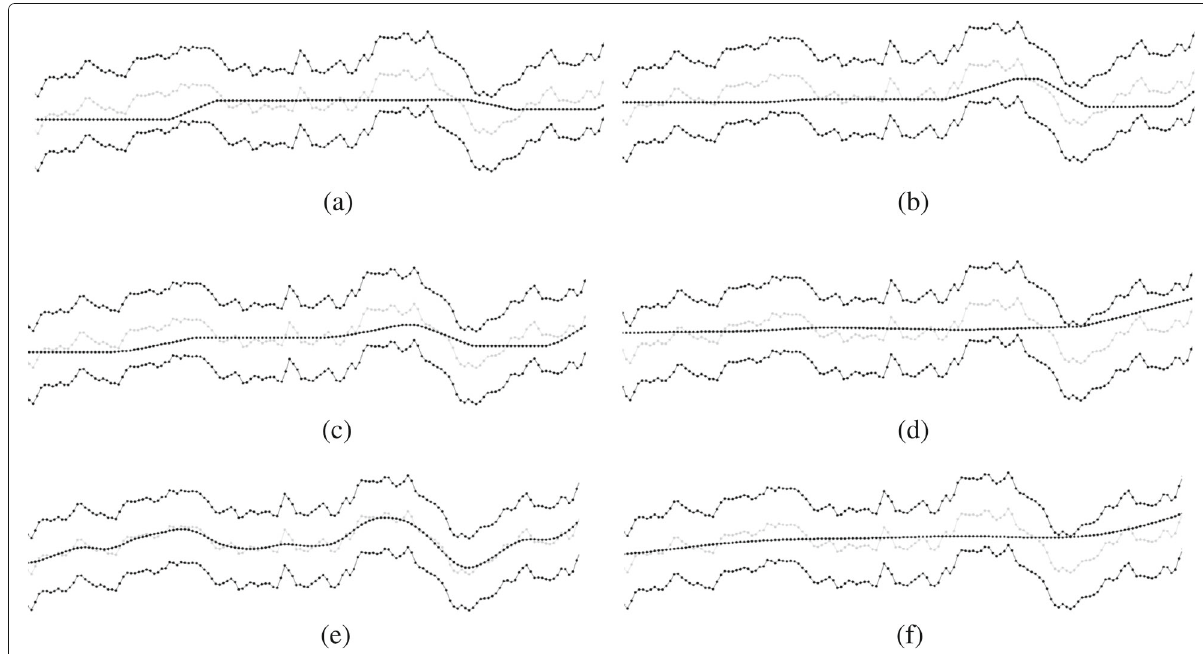
Fig. 12 Simulation results for a video including usual camera motion. a P 2,10% ( K = 2, proposed), b P 5,10% ( K = 5, proposed), c P 10,10% ( K = 10, proposed), d P 60,10% ( K = 60, proposed), e LPF 10 ( K = 10, low-pass filter), and f LPF 60 ( K = 60, low-pass filter). Weights for the proposed algorithm are set at (0.01, 0.01, 10). Image margin is set at